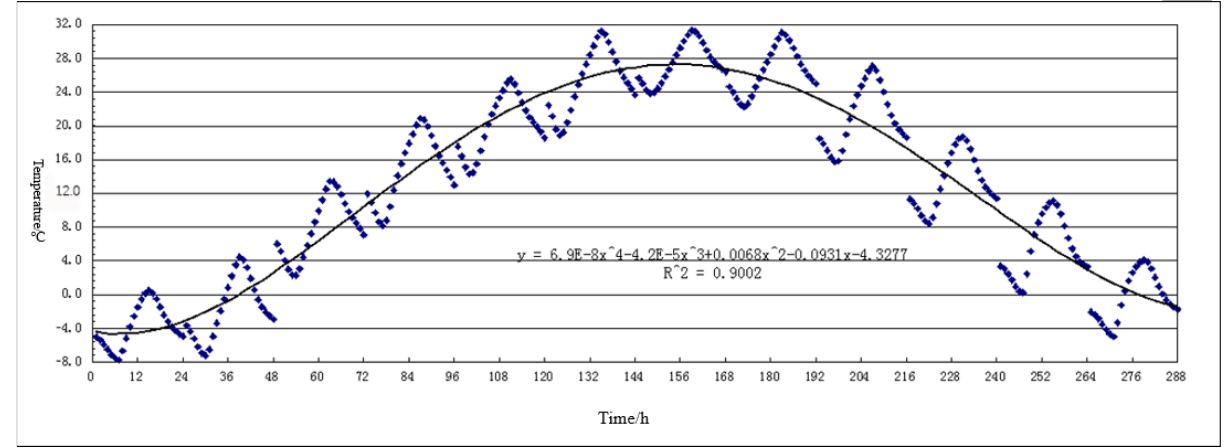
Figure 7. Temperature meteorological model of standard year of Beijing.